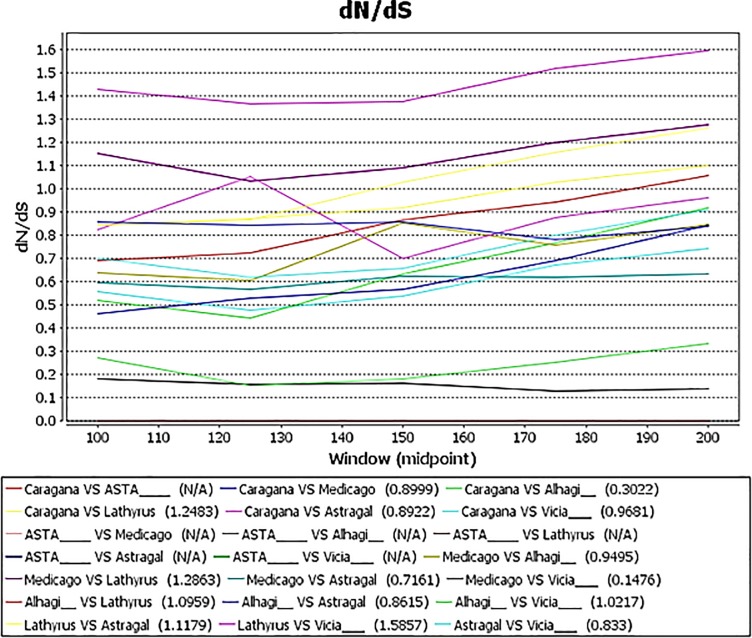
JCoDA output using sliding window analysis of pairwise taxa dN/dS.All parwise comparisons were performed using a window 100. All pairwise comparisons suggested positive selection of ycf4 in Lathyrus.